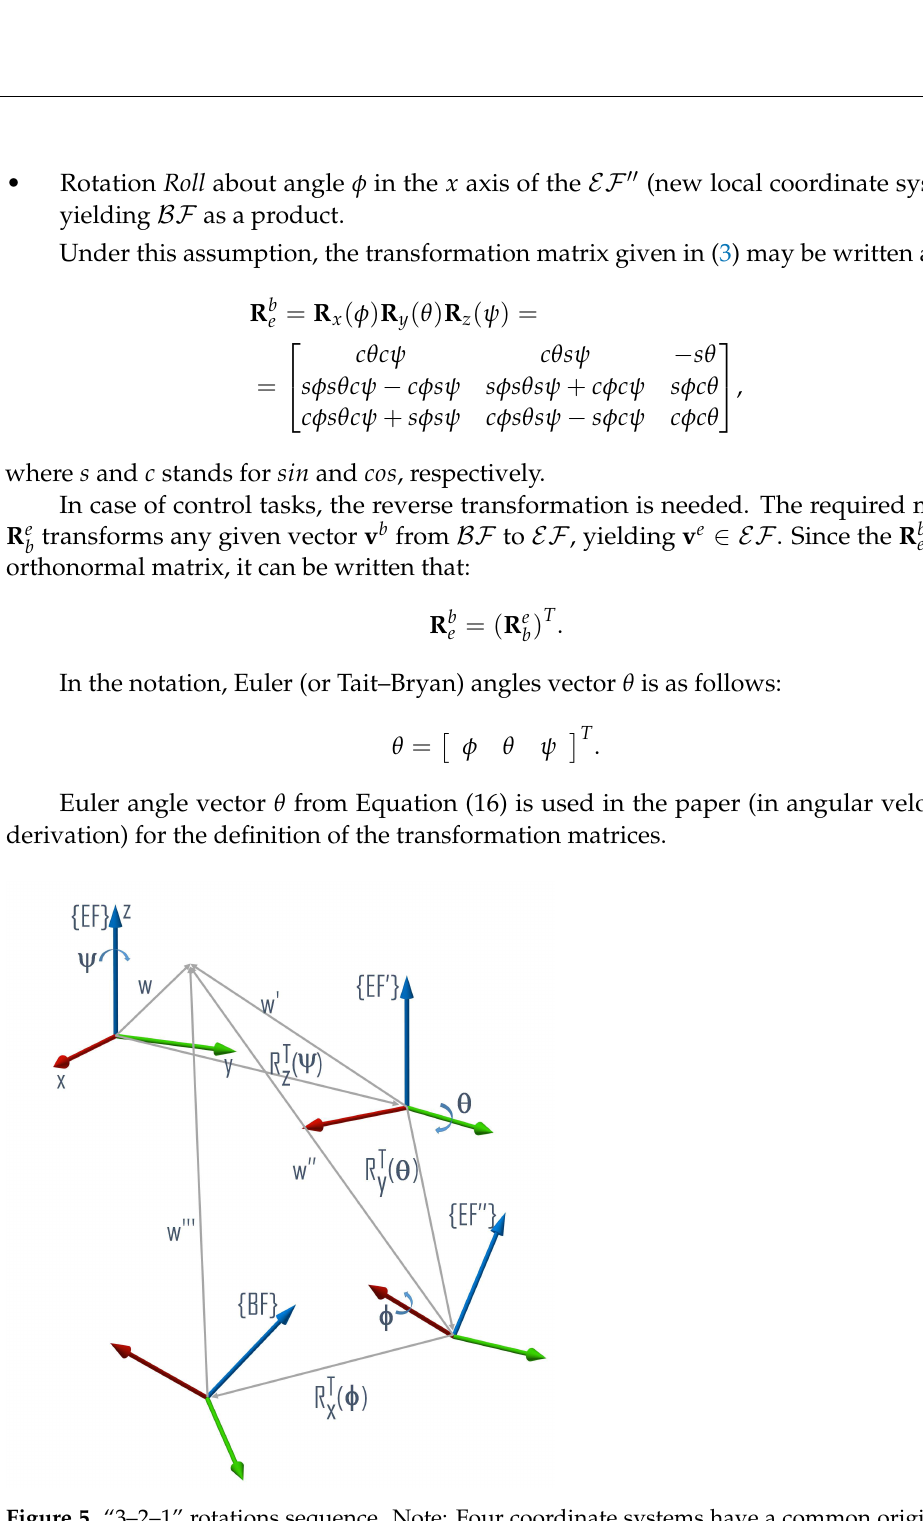
Figure 5. “3–2–1” rotations sequence. Note: Four coordinate systems have a common origin. For better graphical presentation they have been